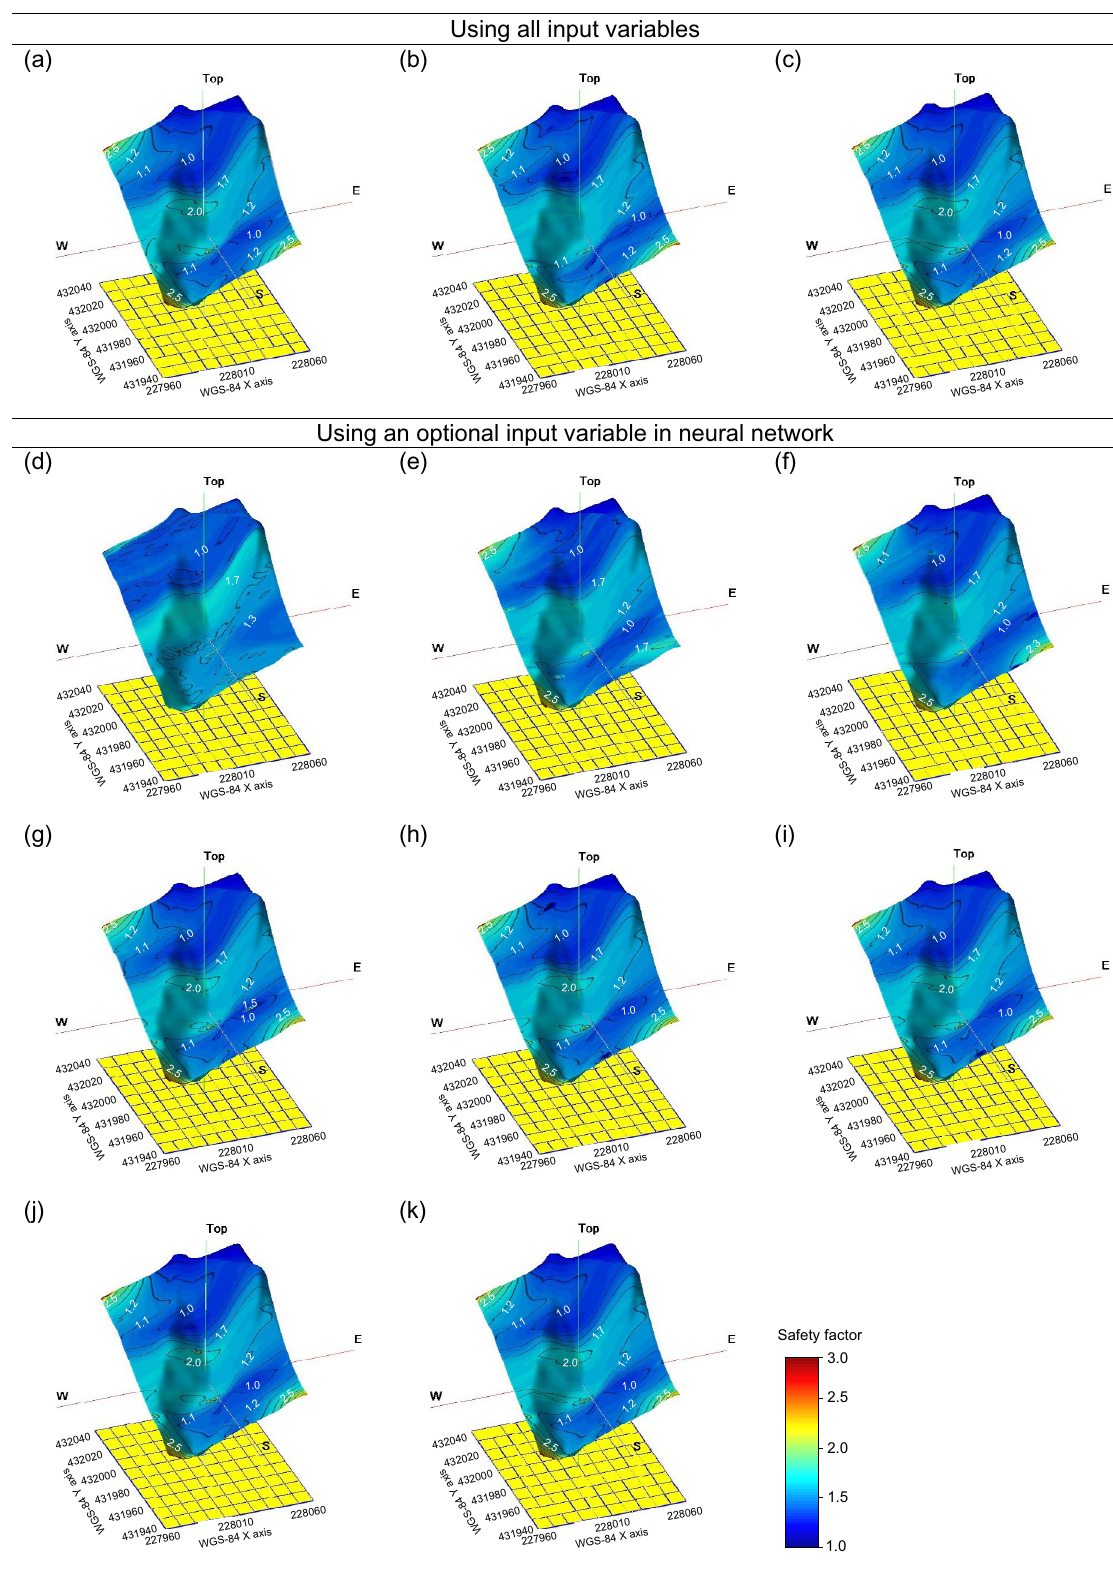
Figure 21. Safety factor modeling based on: ( a ) Eq. (1), ( b ) linear regression; ( c ) neural network; ( d ) 1 parameter; ( e ) 2 parameters; ( f ) 3 parameters; ( g ) 4 parameters; ( h ) 5 parameters; ( i ) 6 parameters; ( j ) 7 parameters; ( k ) 8 parameters. The software of SGeMS beta (v.2.5b) was applied to draw this